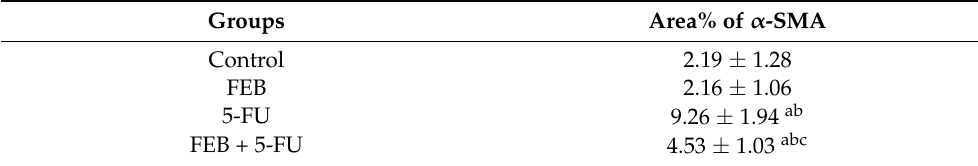
Table 4. Changes in area% of α -smooth muscle actin.